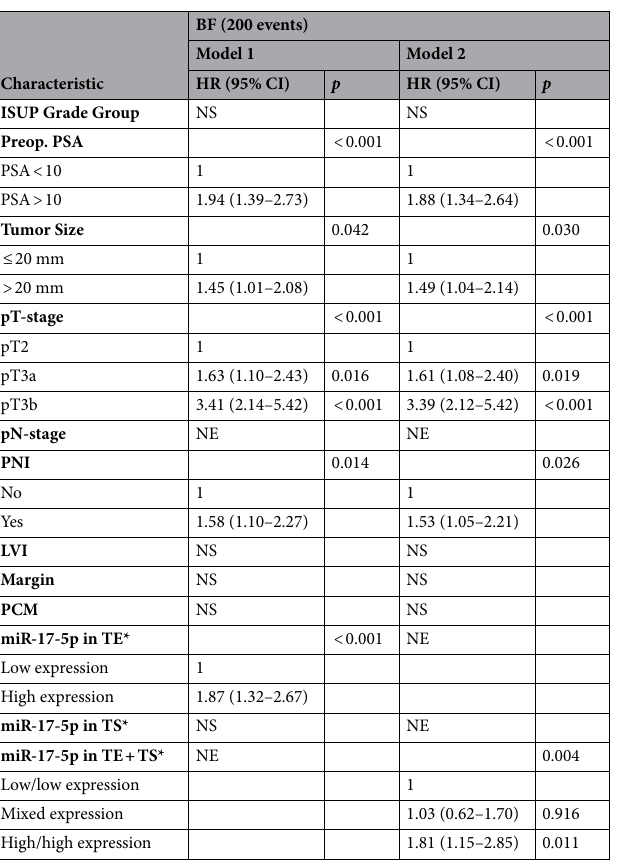
Table 2. Expression of miR-17-5p and significant clinicopathological variables independent prognostic impact on BF (Cox regression analyses, n = 535). Multivariate analysis with p ≤ 0.05 from the univariate analyses (Table 1 and Supplementary Table S1). *The variables TE and TS was included in the same model, while the TE + TS variable was in a separate model. Abbreviations: BF = biochemical failure; CF = clinical failure; LVI = lympho-vascular infiltration; NE = not entered; NS = not significant; p = p-value; PAM = positive apical margin; PCM = positive circumferent margin; PNI = perineural infiltration; Preop = preoperative; PSA = prostate specific antigen; TE = tumor epithelium; TS = tumor stroma.